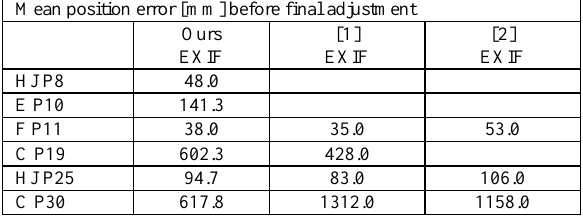
Table 1. Comparison of mean position errors before final